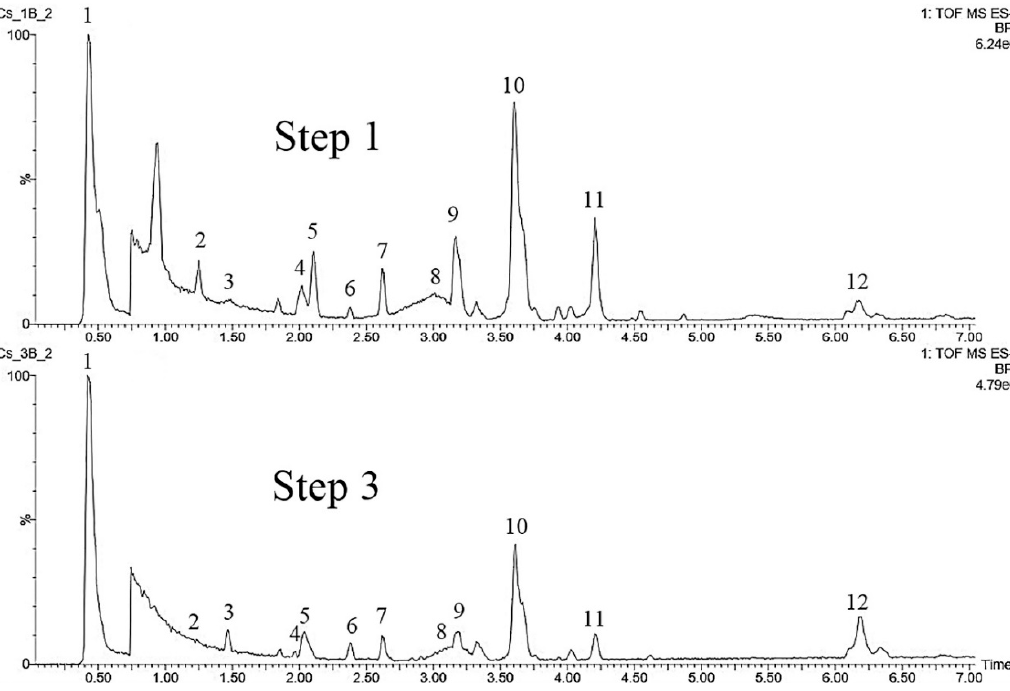
Figure 8. Base peak ion chromatograms comparing steps 1 to 4 of the leaf explants from Calycophyllum spruceanum.